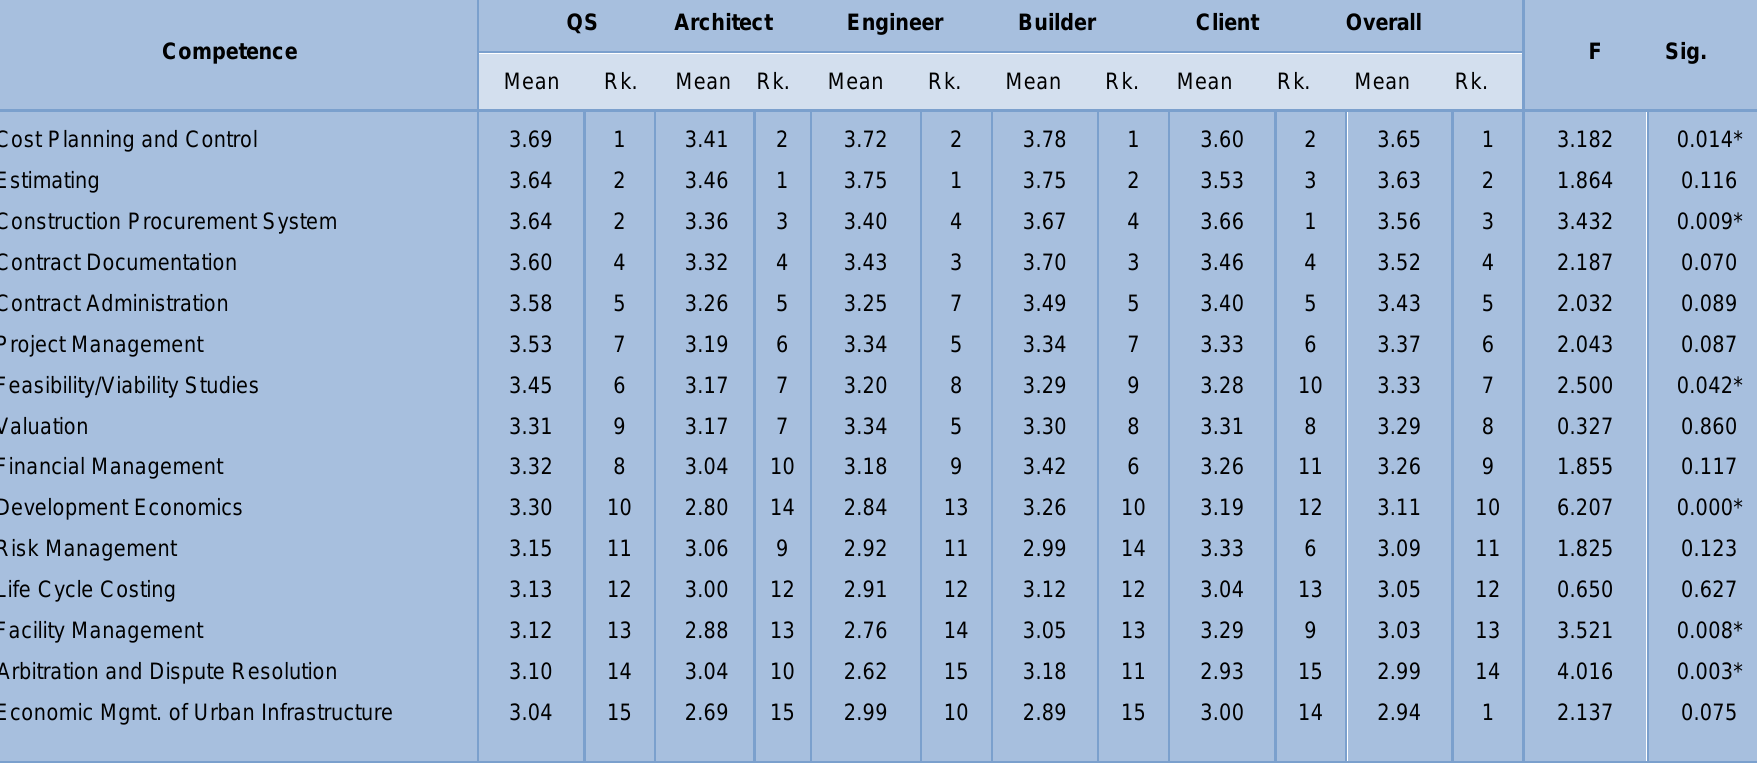
Table 3 Competencies Expected of Quantity